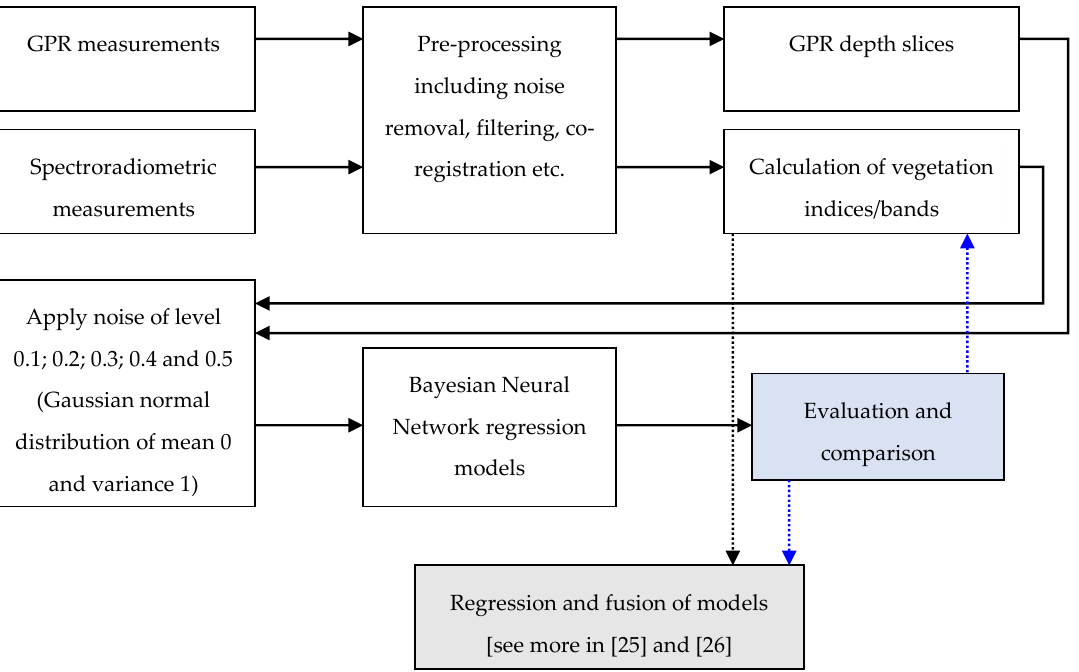
Figure 2. Overall methodology followed in this study.